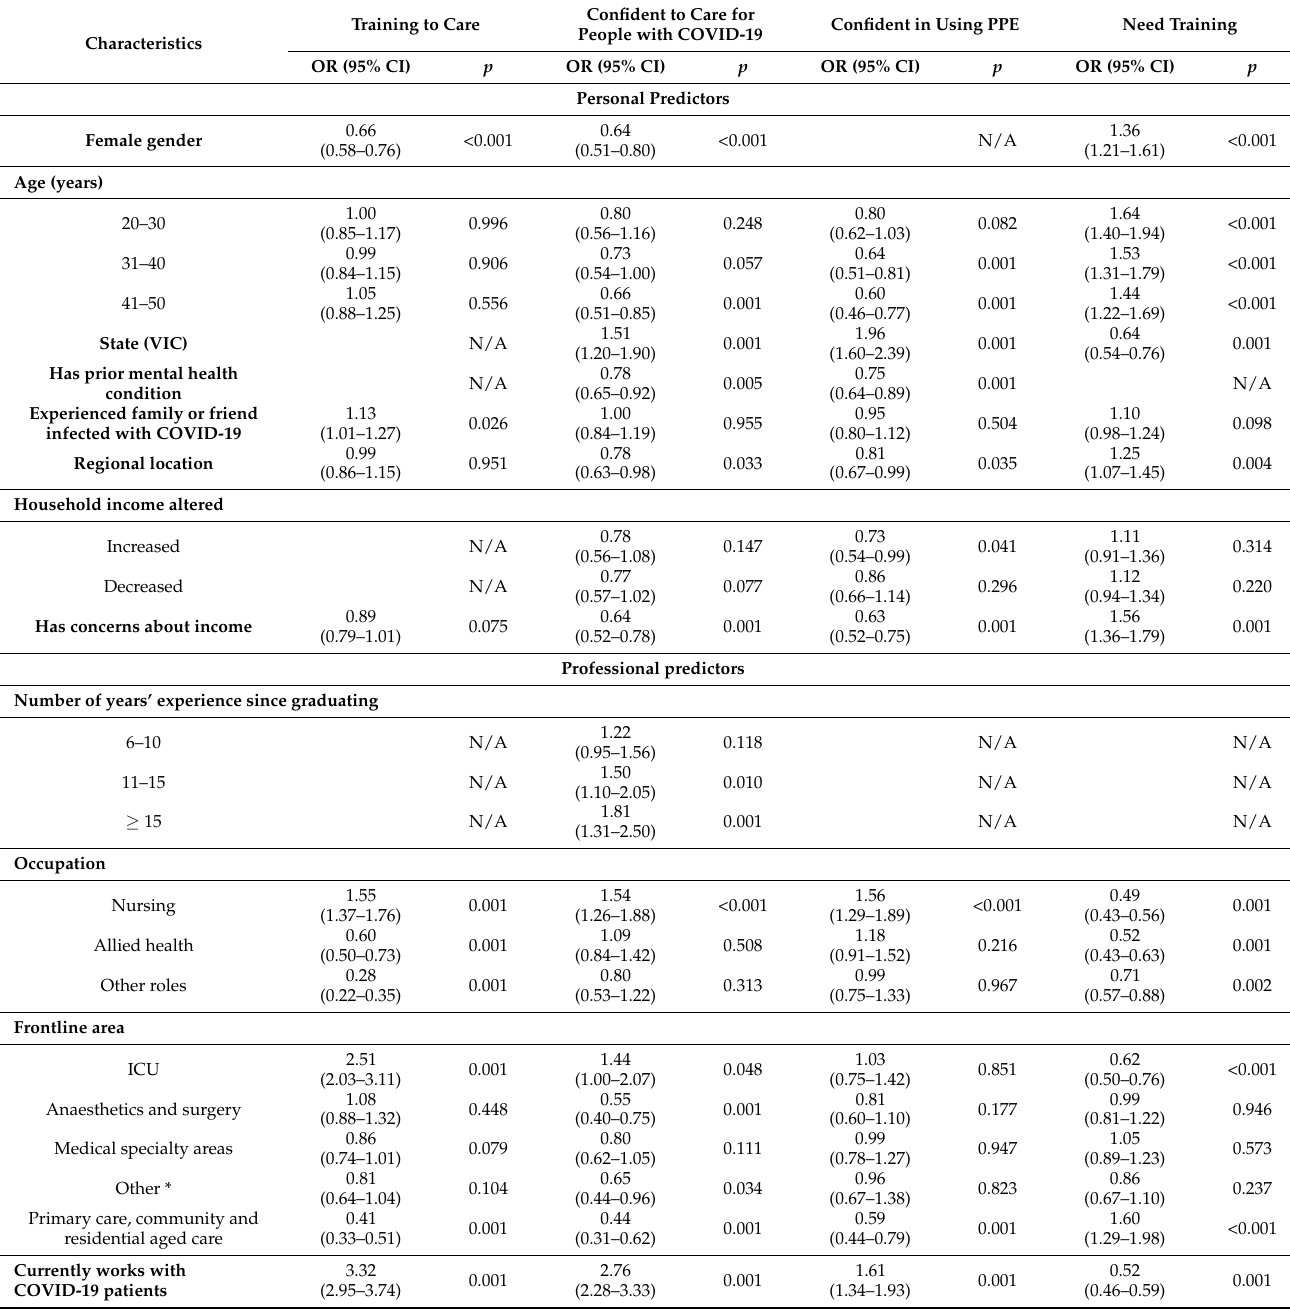
Table 4. Predictors of training and